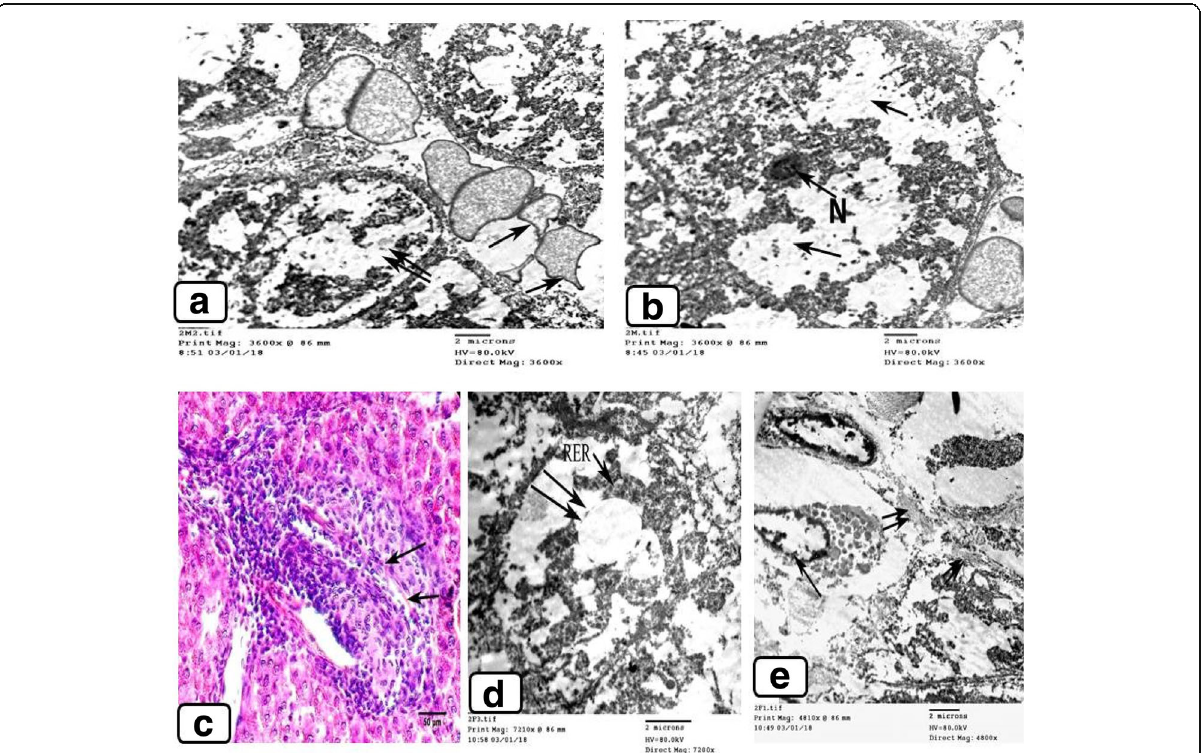
Fig. 6 a Ultrastructure of the M3 group hepatocytes showing congested blood sinusoid with abnormal shaped RBCs and thickened of their plasma membrane ( ↑ ). Note: apoptotic cell ( ↑↑ ). b Ultrastructure of the M3 group hepatocytes showing large parts of cytoplasm depleted completely from cellular organelles ( ↑ ) and with pyknotic nuclei (N). c F3 group liver showing large foci of leucocytic aggregation with deposition of the amount of fibers ( ↑ ) (H&E). d Ultrastructure of F3 group hepatocytes showing large lipid droplet ( ↑↑ ) between fragmented rough endoplasmic reticulum (RER) and other organelles ( ↑ ). e Ultrastructure of F3 group hepatocytes showing activated mast cell and their nuclei with condensed chromatin ( ↑ ) and many amounts of collagenous fibers between liver cells ( ↑↑